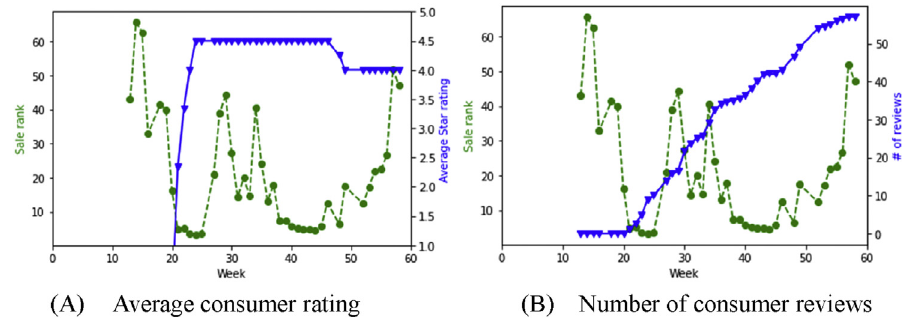
Fig. 1. Product with many reviews. Panel (A) shows the evolution of the sale rank (circle, left vertical axis) and the average consumer rating (inverted triangle, right vertical axis). Lower sales rank indicates higher popularity. Panel (B) shows the evolution of the sale rank (circle, left vertical axis) and the number of reviews (inverted triangle, right vertical axis).